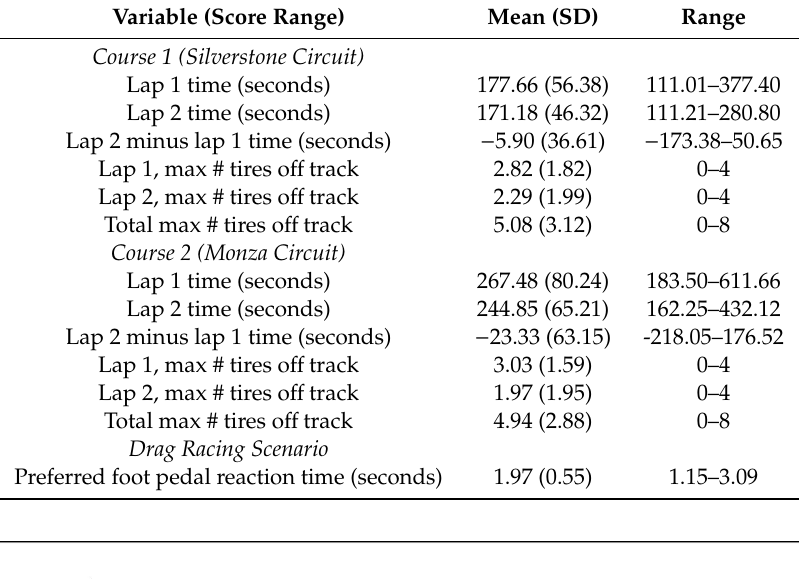
Table 6. Study sample performance in the low-cost racing simulator.